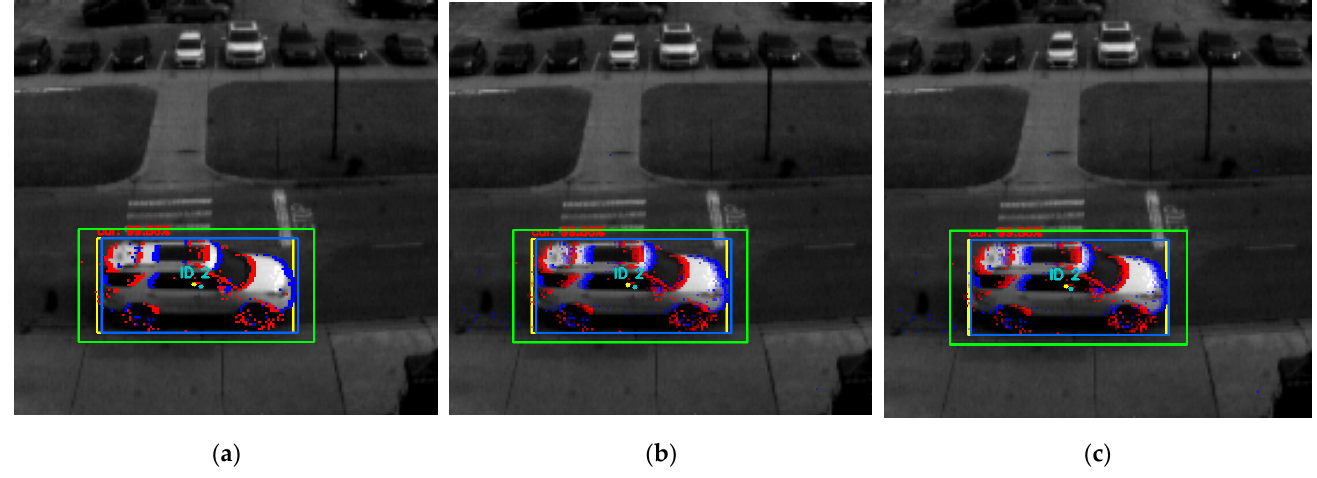
Figure 6. Inter-frame tracking output at 48 Hz in three different modes: ( a ) event-based mask with a discrete-step moving window with no temporal weighting; ( b ) event-based mask with temporally weighted events in a 50 ms moving window frame; ( c ) edge-based mask with temporally weighted events in a 50 ms moving window frame. The inter-frame object position is highlighted by the light-blue bounding box (cyan dot represents its centroid), whereas the yellow bounding box and dot represent the object’s position and centroid in the latest image frame, respectively.